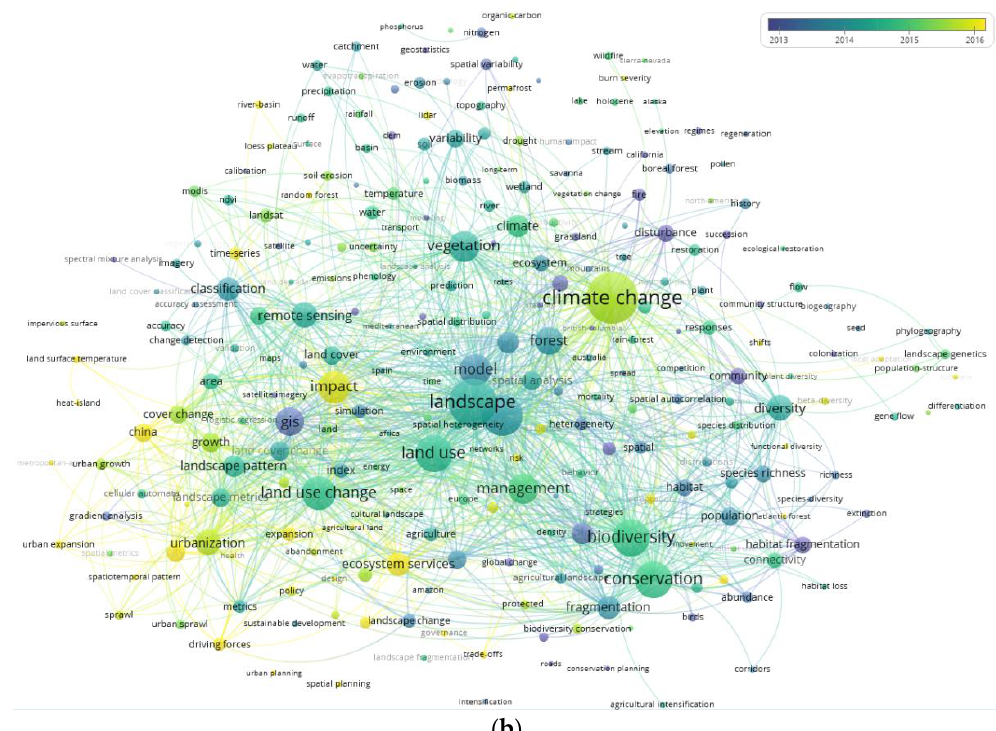
Figure 5. ( a ) Co-occurrence map (period: 2001 – 2020); ( b ) overlay visualization between key terms and their citation year. Graphs made with VOSviewer software.